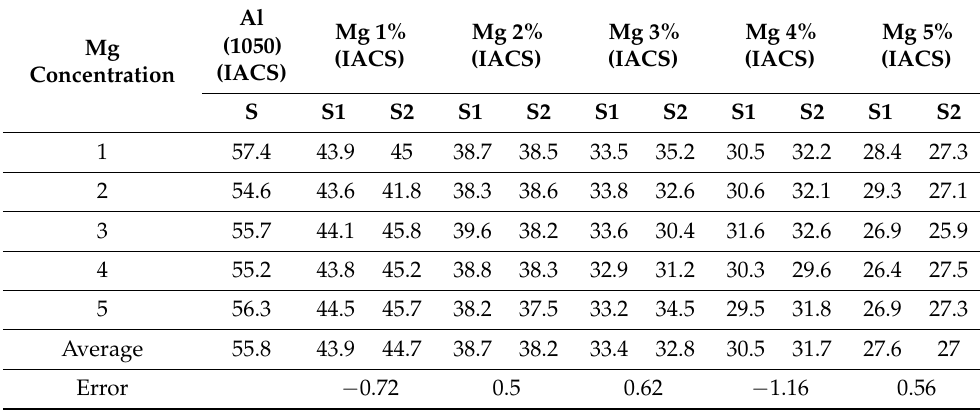
Table 7. Electrical conductivity test results for Al (1050) alloy with different Mg percentiles.